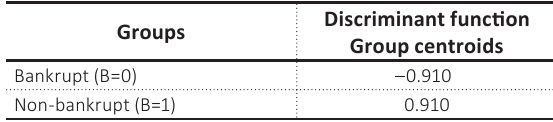
Table 15. Group centroids ( t –3)